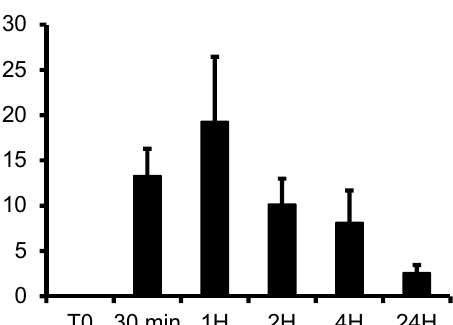
Figure 2. Plasma kinetic of gallic acid after intraperitoneal injection of tannic acid at 50 mg/kg in rat. Gallic acid was determined in plasma collected from 30 min to 24 h, by high pressure liquid chromatography method coupled with spectrophotometry, n = 3–4 at each times. Values are mean ± SD.